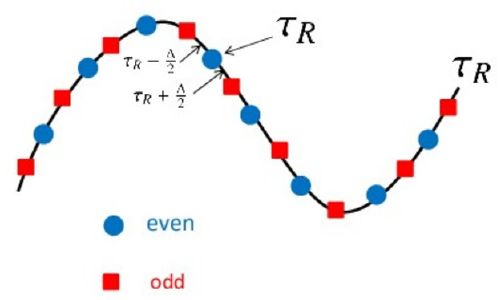
Figure 15 . The string consists of a series of even and odd objects along the string alternatively put. As is depicted as an example the string is parametrized in the following manner. The right mover is parametrized by (cid:28) R . If the one even object is in (cid:28) R , the neighboring two objects are odd ones: one of them is situated at (cid:28) R (cid:0) (cid:1) and the other is at (cid:28) R + (cid:1) , where (cid:1) is the cut o(cid:11) length 2 2 into